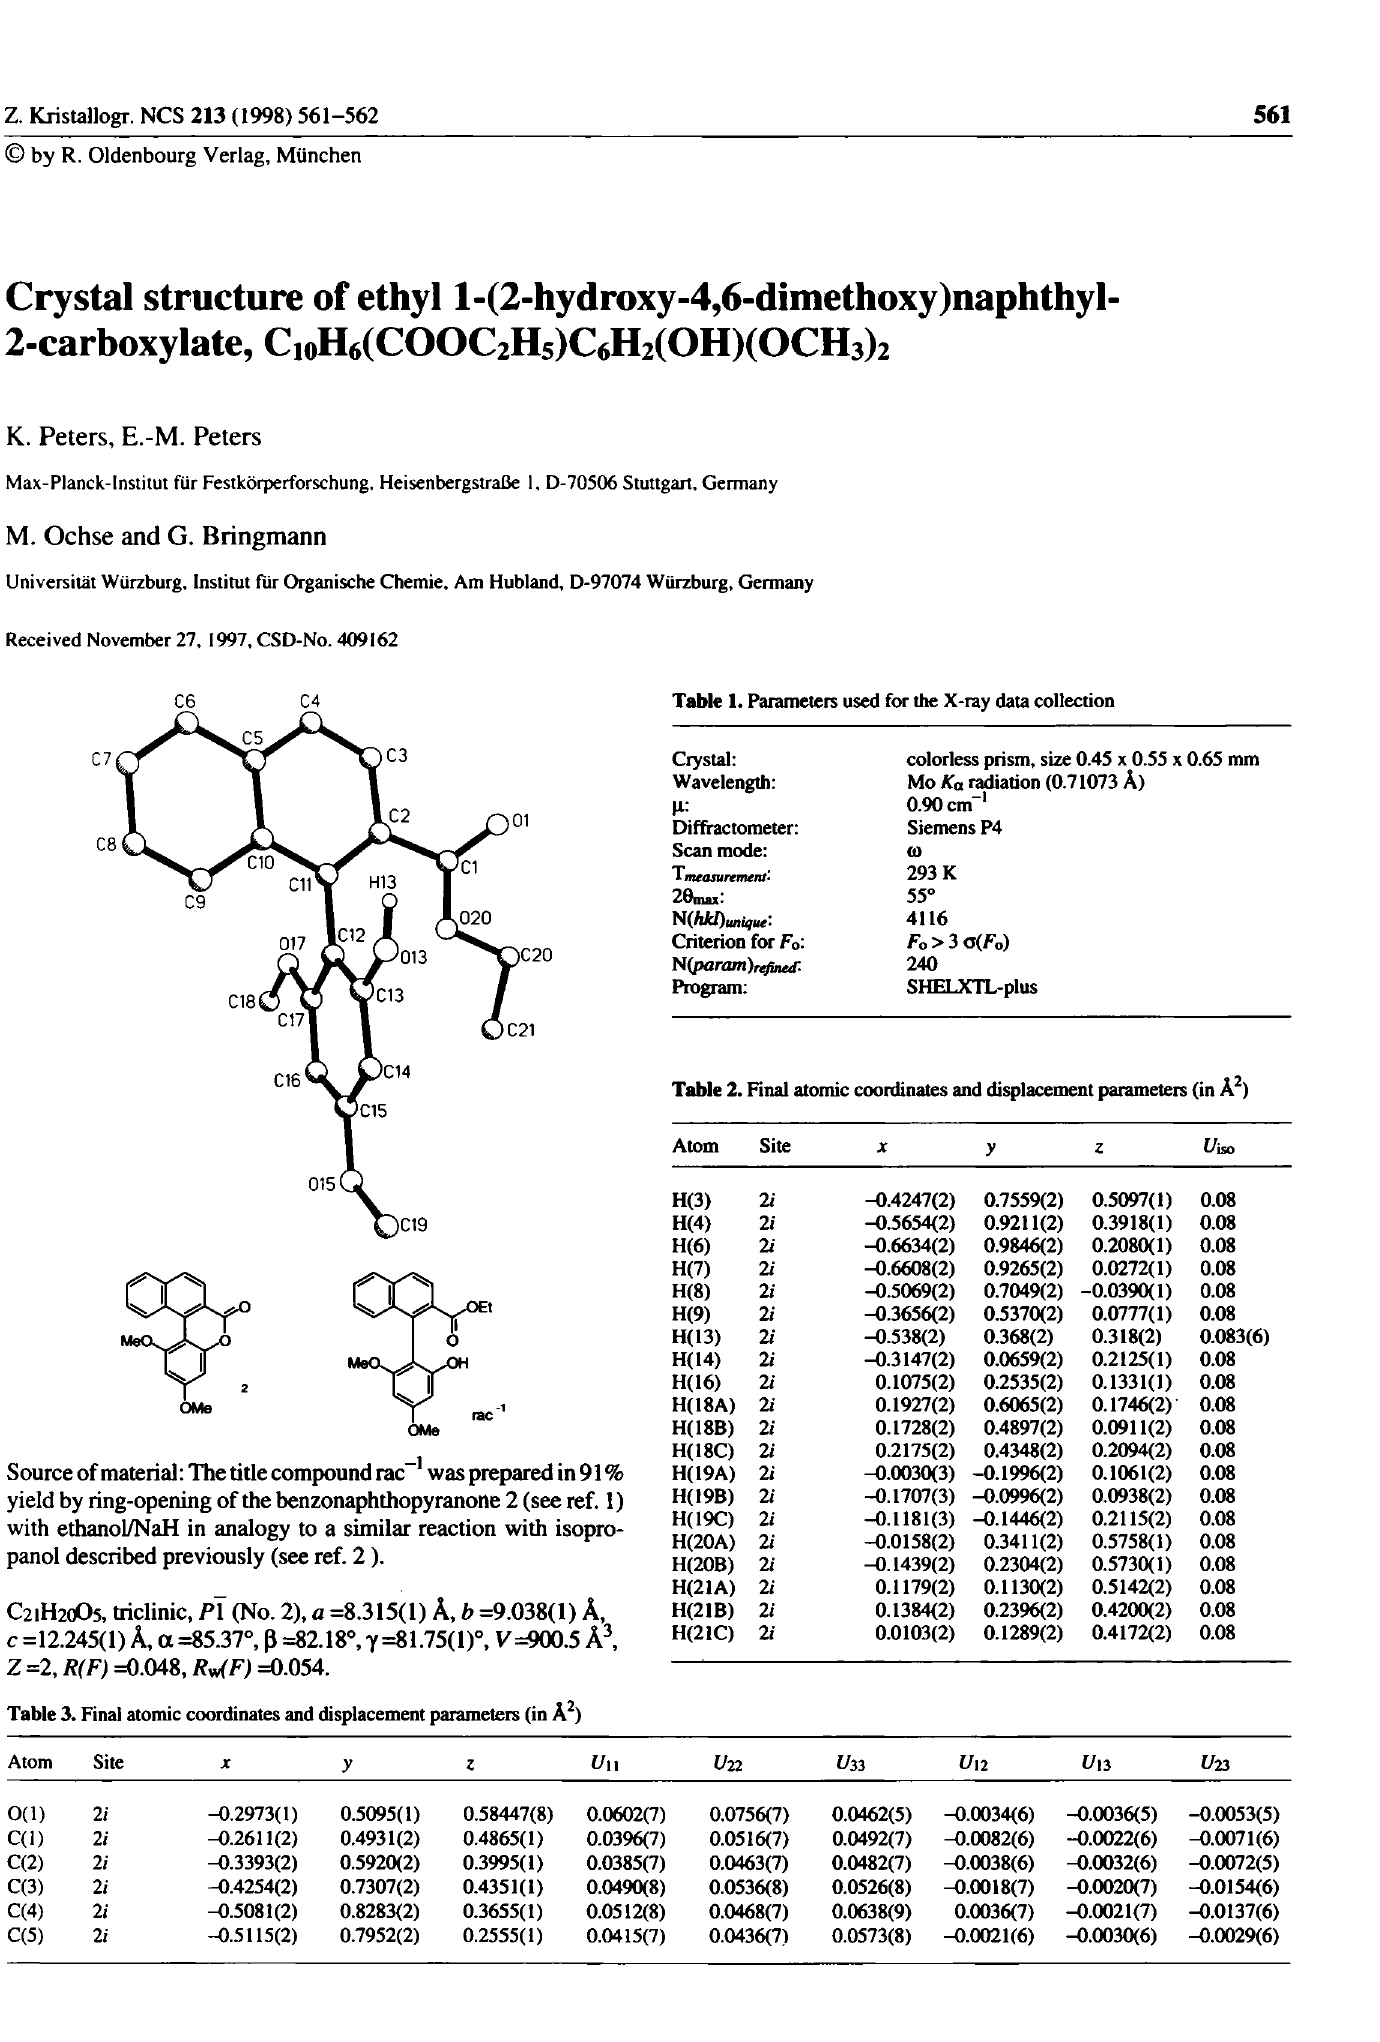
Table 3. Final atomic coordinates and displacement parameters (in Â^)